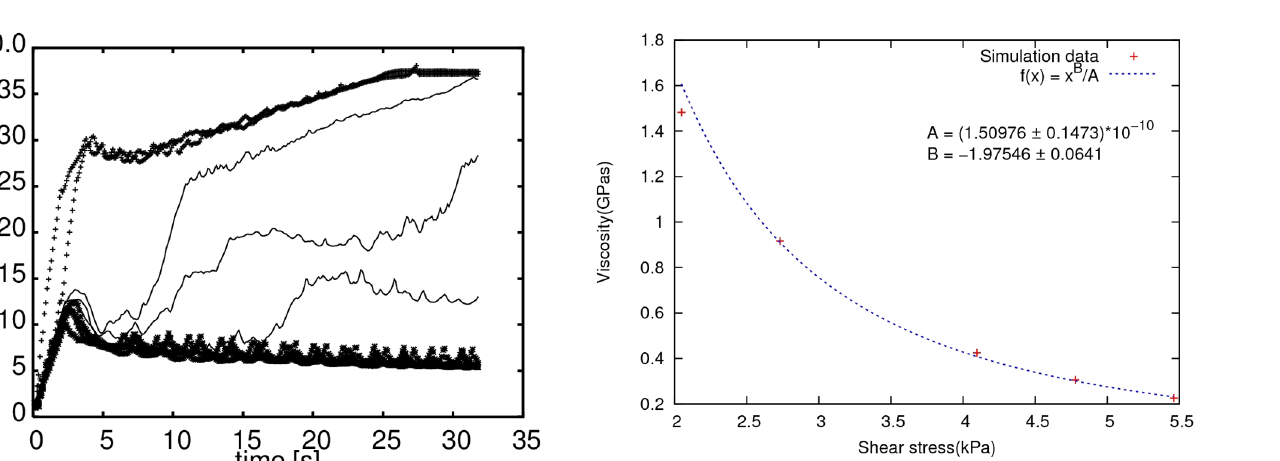
Fig. 8. The kinetic energy ( E kin ) as function of time for “surging” simulations exemplified by Figs. 6 and 7 for 7 different simulations. The cases when the ice-block is the entire time in either the surging or the quiescent phase the energy is indicated by discrete markers. For the blocks for which a phase transition appear, the kinetic en- ergy is represented by continuous lines.